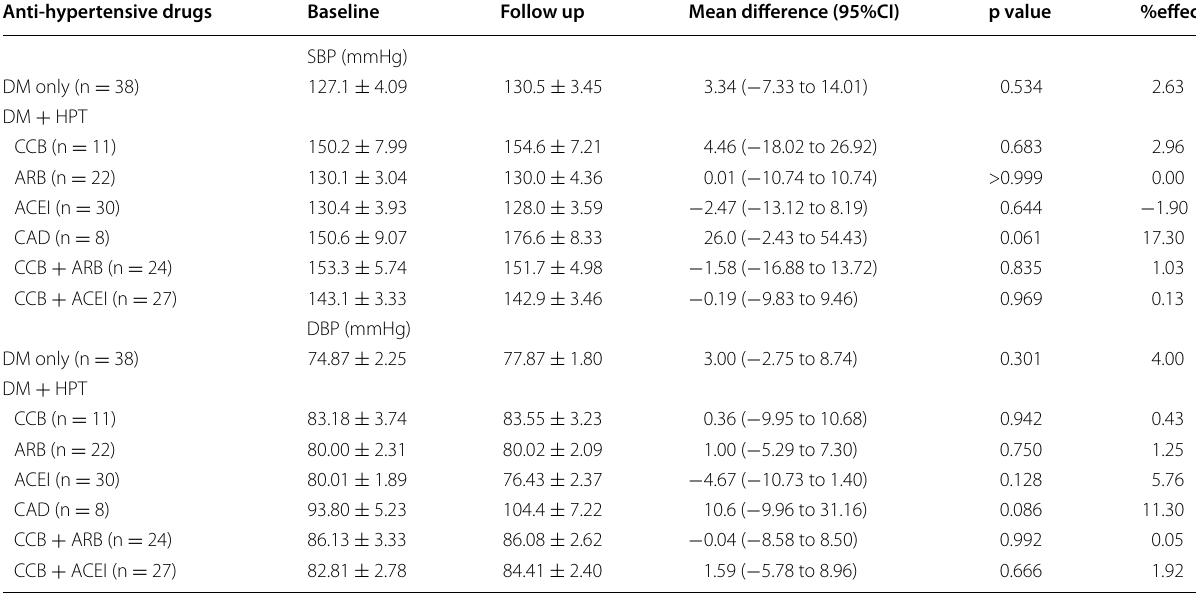
CCB calcium channel blockers, ACEI angiotensin converting enzyme inhibitors, ARB angiotensin II receptor blockers, CAD central acting drugs